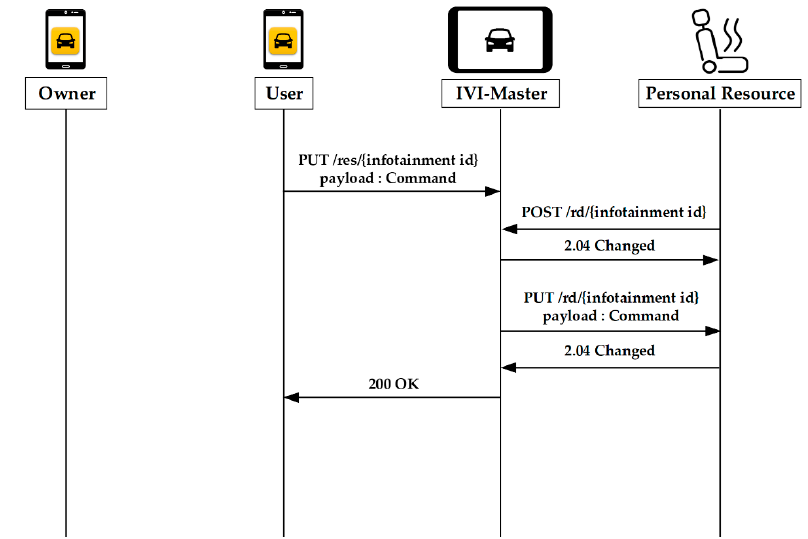
Figure 11. Control of personal resources by user.